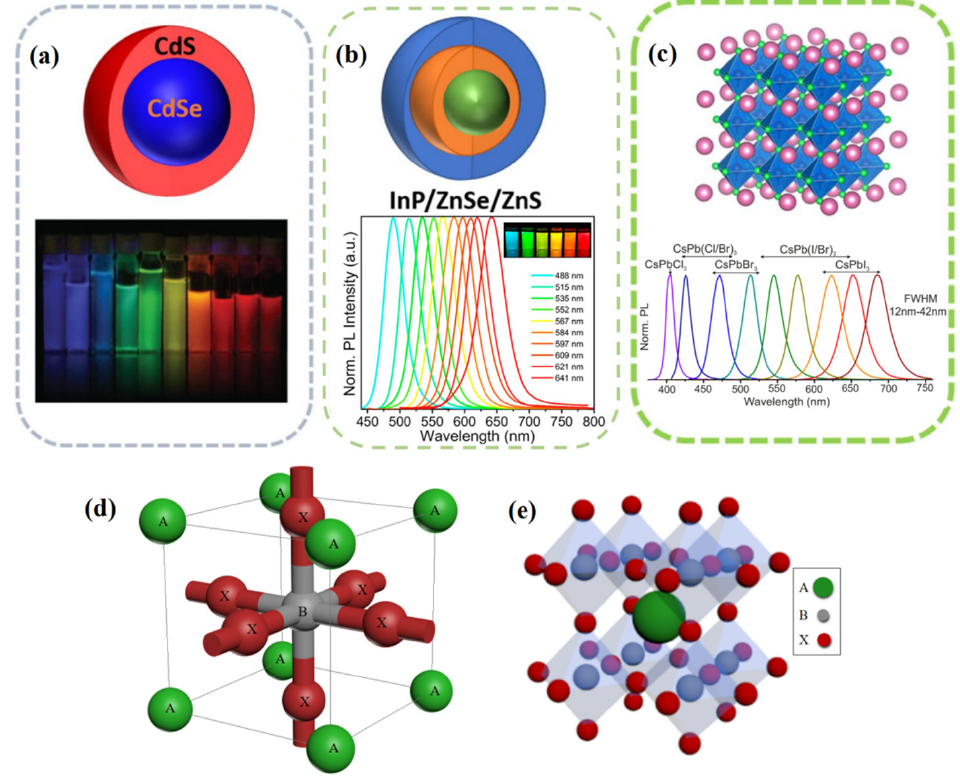
Figure 1. ( a ) CdSe-based QDs. ( b ) InP-based QDs. ( c ) PQDs. Adapted with permission from [22]. perovskite ABX 3 .